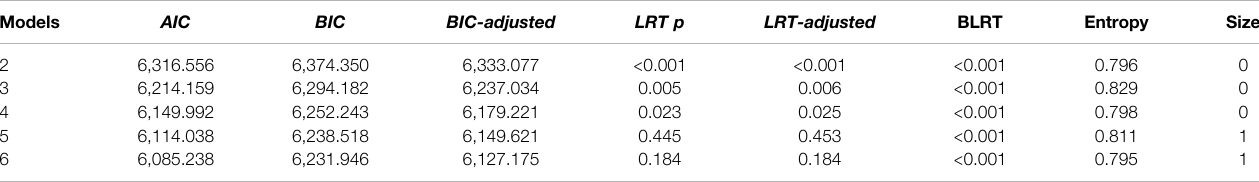
TABLE 1 | Data fi t of all models .